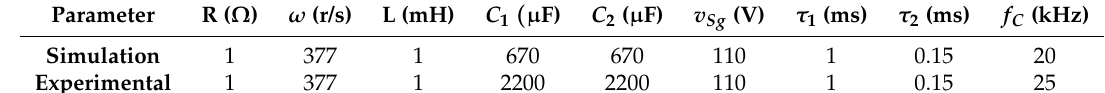
Table 2. Parameters on simulation and experimentals.